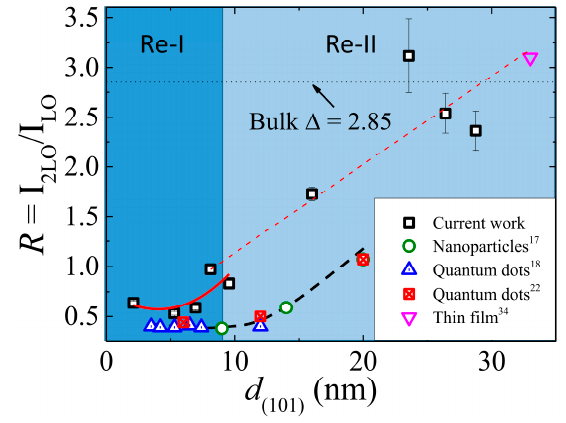
Figure 4. A plot of d (101) dependency of EPC strength in the current work compared with that reported for nanoparticles [17], quantum dots [18,22], and thin granular film [34], where the horizontal dotted line indicates the bulk ZnO value of 2.85. The solid red color line represents a fit as discussed in the text, whereas the straight red and black dashed lines are guides for the eye.